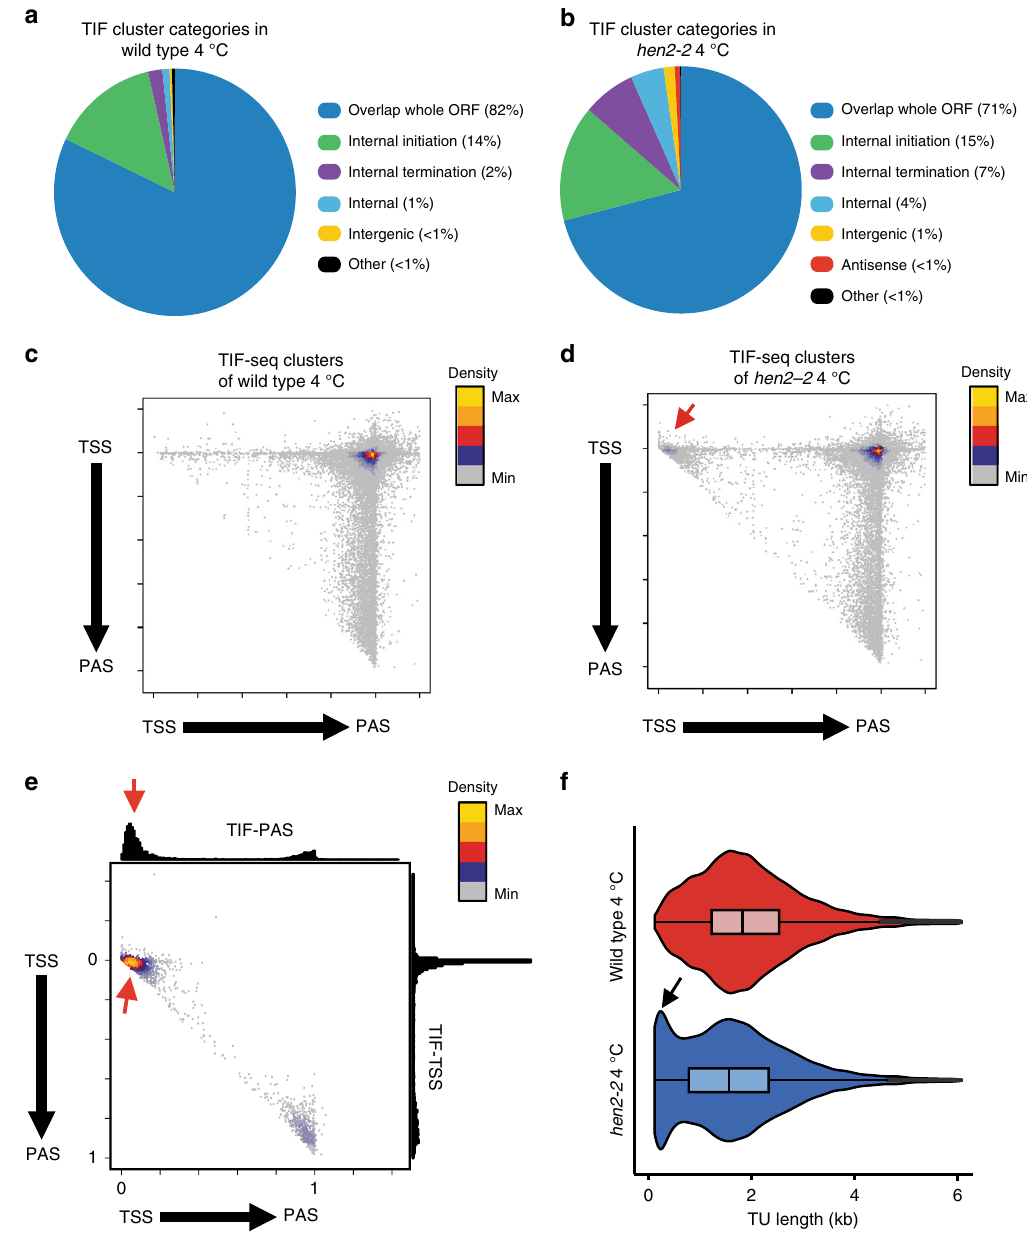
Fig. 4 Transcript isoform mapping during the response to cold temperature. a Pie chart of TIF-cluster categories in 4 °C-treated wild type. b Pie chart of TIF-cluster categories in 4 °C-treated hen2-2 . c Scatterplot of TIF-cluster TSS/PAS pairs in 4 °C-treated wild type. d Scatterplot of TIF-cluster TSS/PAS pairs in 4 °C-treated hen2-2 . e Scatterplot of <300 bp TIF-cluster TSS/PAS pairs in hen2-2 . Histograms and bar plots display TIF-TSSs/-PASs distribution normalised to gene length from annotated TSS to PAS. The colour scale in c – e represents 2D position enrichment density of clusters from low (grey) to high (yellow). f TIF-cluster sizes in 4 °C-treated wild type and hen2-2 . Black arrow indicates enrichment of short transcripts in 4 °C-treated hen2-2 , the box bounds the iQR divided by the median, and whiskers extend to a maximum of 1.5× iQR beyond the box. Source data of a , b are provided in the Source Data fi